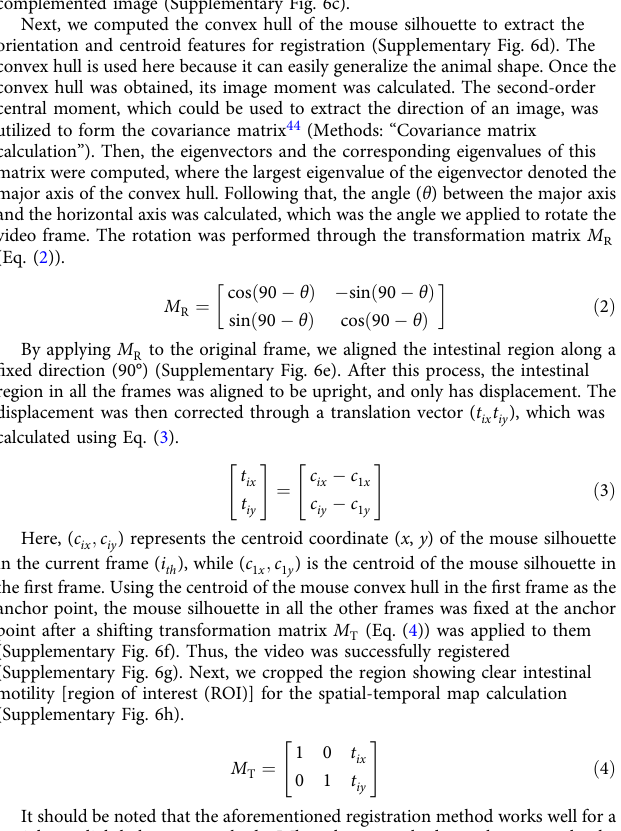
The setup allows us to spectrally resolve the movement of two contrast